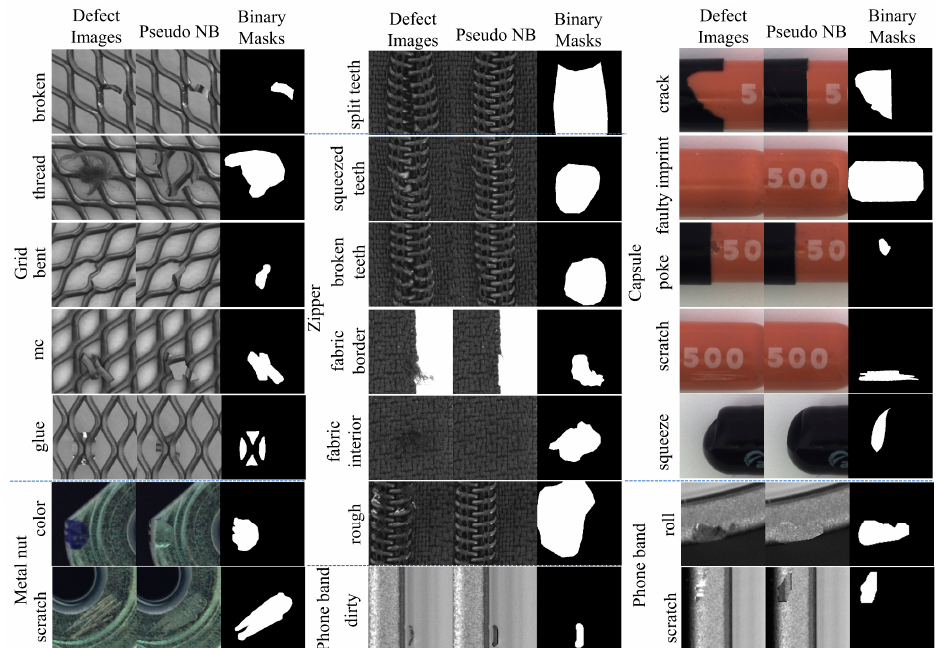
Figure 3. Non-uniform structure images in training sets. Defect Images (256 2 ) are cropped from the original real images. Pseudo NB (256 2 ) are the cropped constructed pseudo-normal backgrounds. Binary Masks (256 2 ) are the cropped binary annotation images. In particular, the size of training images in Capsule and phone band were 320 2 and 128 2 , respectively. Table 1. The number of datasets (original/cropped images). Training means the training sets of MDGAN. EL/AUG means the number of augmented samples from MDGAN ( EL ) and traditional methods ( AUG ). RAW and Seg-test are the real training and testing sets of segmentation, respectively.